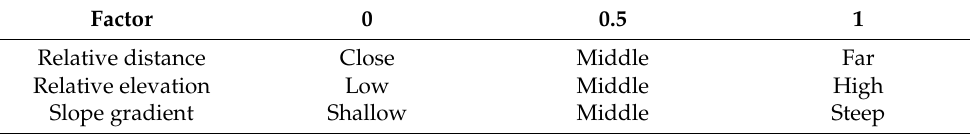
Table 3. Evaluation standard of source and sink landscapes according to three factors. Factor 0 0.5 1 Relative distance Close Middle Far Relative elevation Low Middle High Slope gradient Shallow Middle